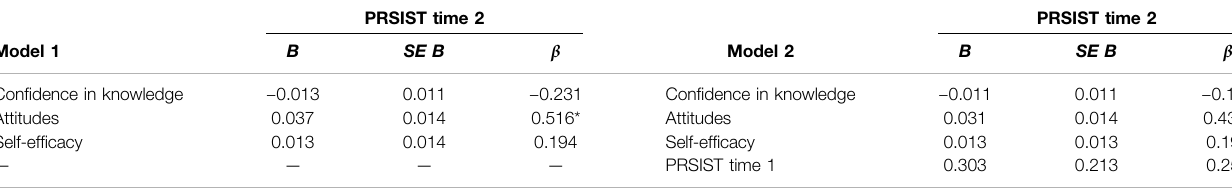
TABLE 4 | Predictors of children ’ s scores on the Preschool Situational Self-Regulation Toolkit (PRSIST) Assessment.